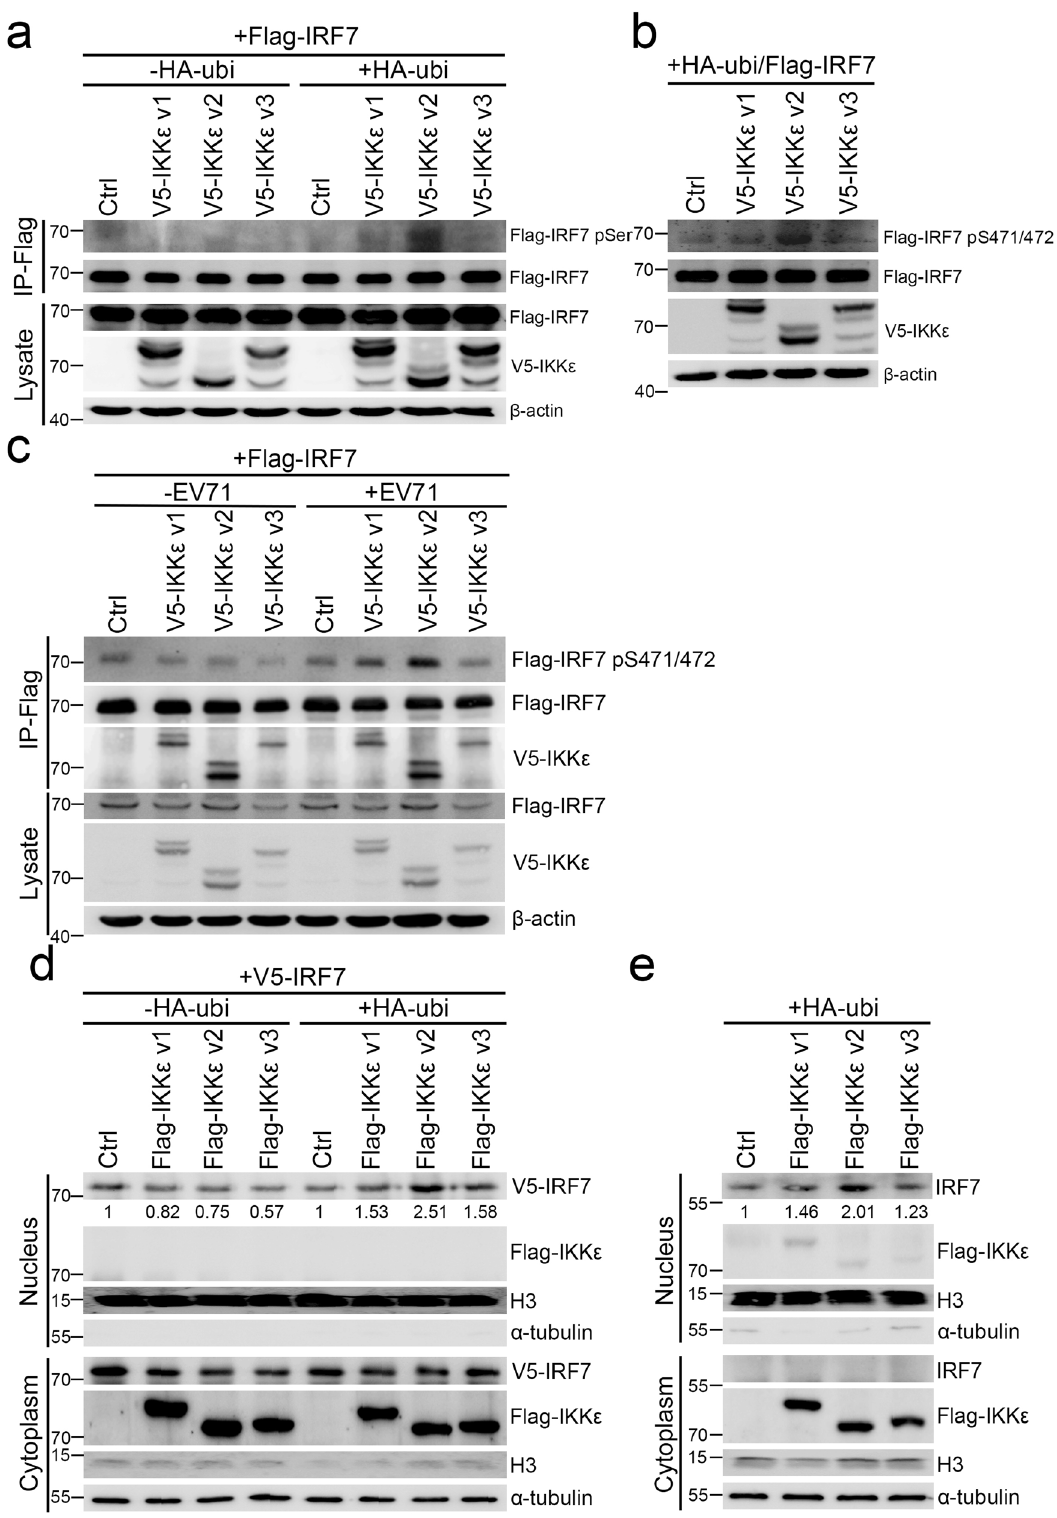
IKK ε v2 is highly phosphorylated via K63-linked ubiquitina- tion . It has been well demonstrated that IKK ε is modi fi ed by K63- linked ubiquitin chains and this modi fi cation is essential for IKK ε kinase activation 46,47 . Hence, we fi rst assessed the effects of ubi- quitination on the kinase activity of IKK ε isoforms and deter- mined the differences in K63-linked ubiquitin-mediated activation between each IKK ε isoform. The phospho-serine level